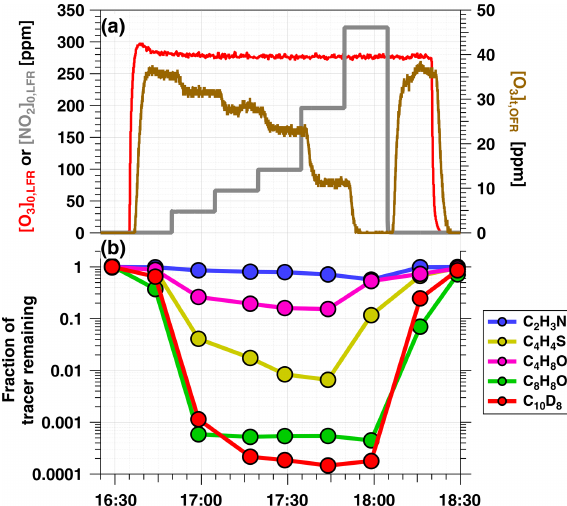
Figure 2. Time series from a representative OFR-iN 2 O 5 characteri- zation experiment conducted at RH OFR = 11% of (a) O 3 and NO 2 mixing ratios input to LFR (left axis) and O 3 measured at the exit of the OFR (right axis), and (b) VOC tracers measured with PTR- MS: acetonitrile (C 2 H 3 N), butanal (C 4 H 8 O), thiophene (C 4 H 4 S), 2,3-dihydrobenzofuran (C 8 H 8 O), and naphthalene-d 8 (C 10 D 8 ).